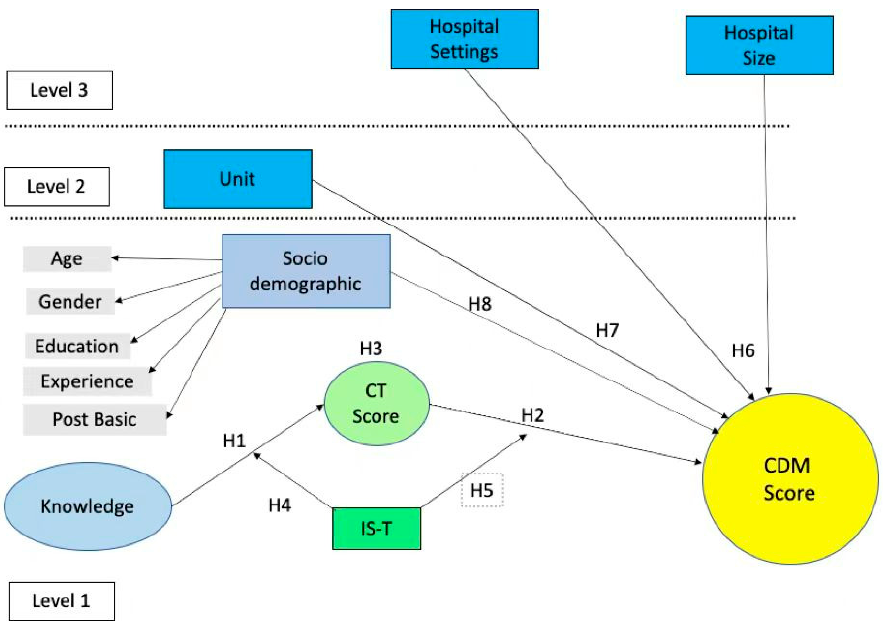
Figure 3. Study flow chart.